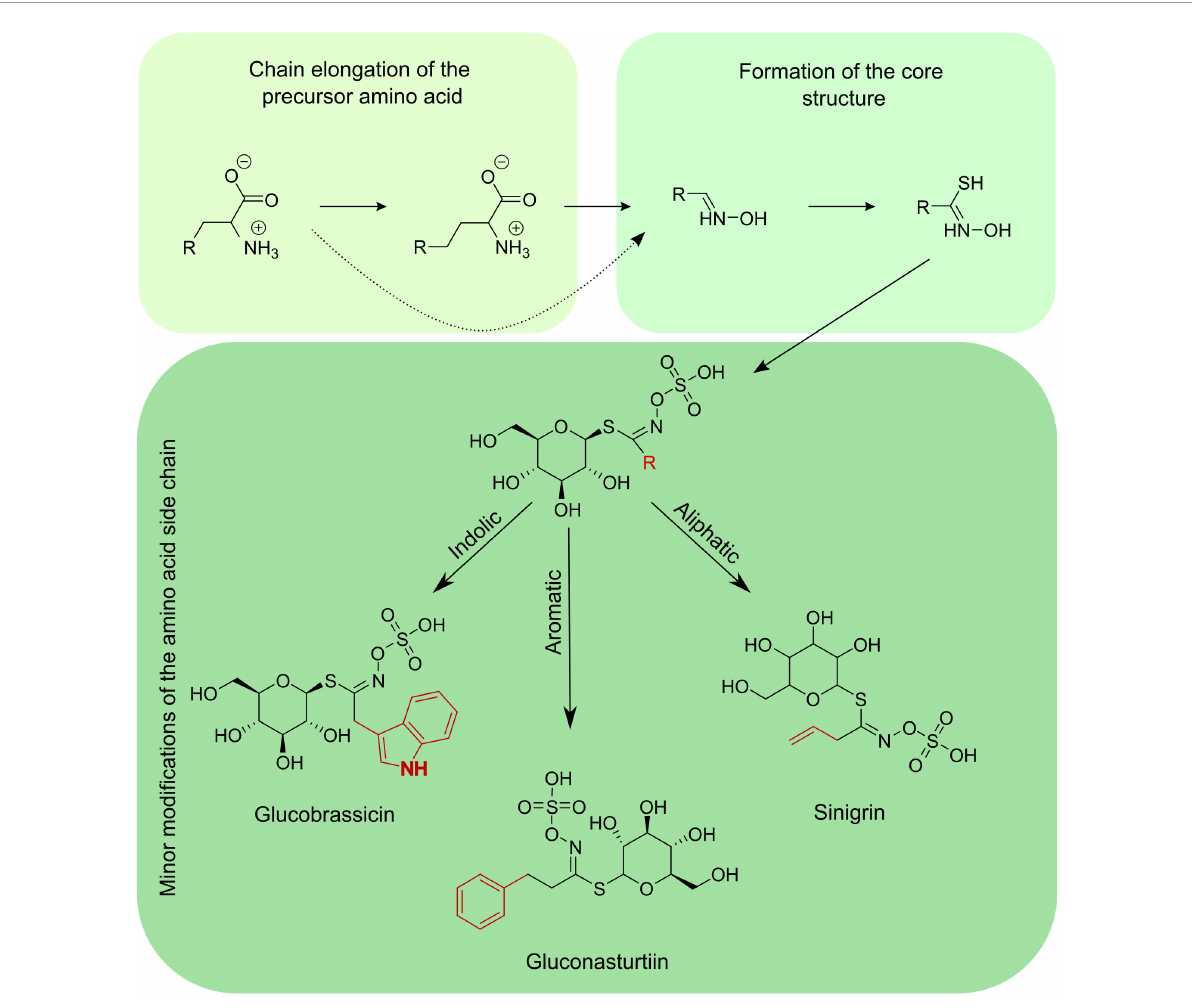
FIGURE2 Diagram showing the three stages of the GSL biosynthetic pathway: chain elongation of the precursor amino acid, formation of the GSL core structure, and minor modifications of the amino acid side chain